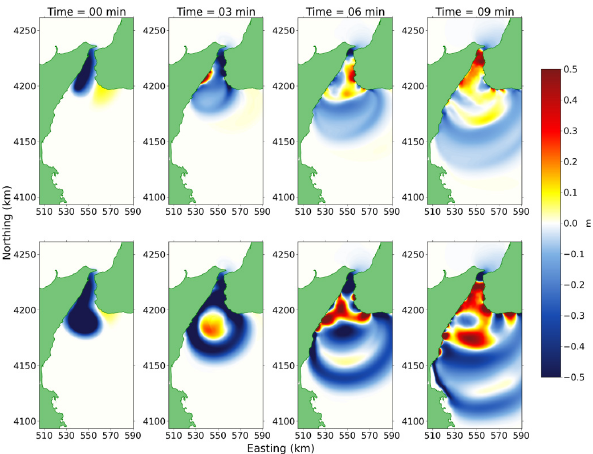
Fig. 10. Tsunami propagation snapshots for 1908 E (upper panels) and 1908 EL (bottom panels) scenarios.